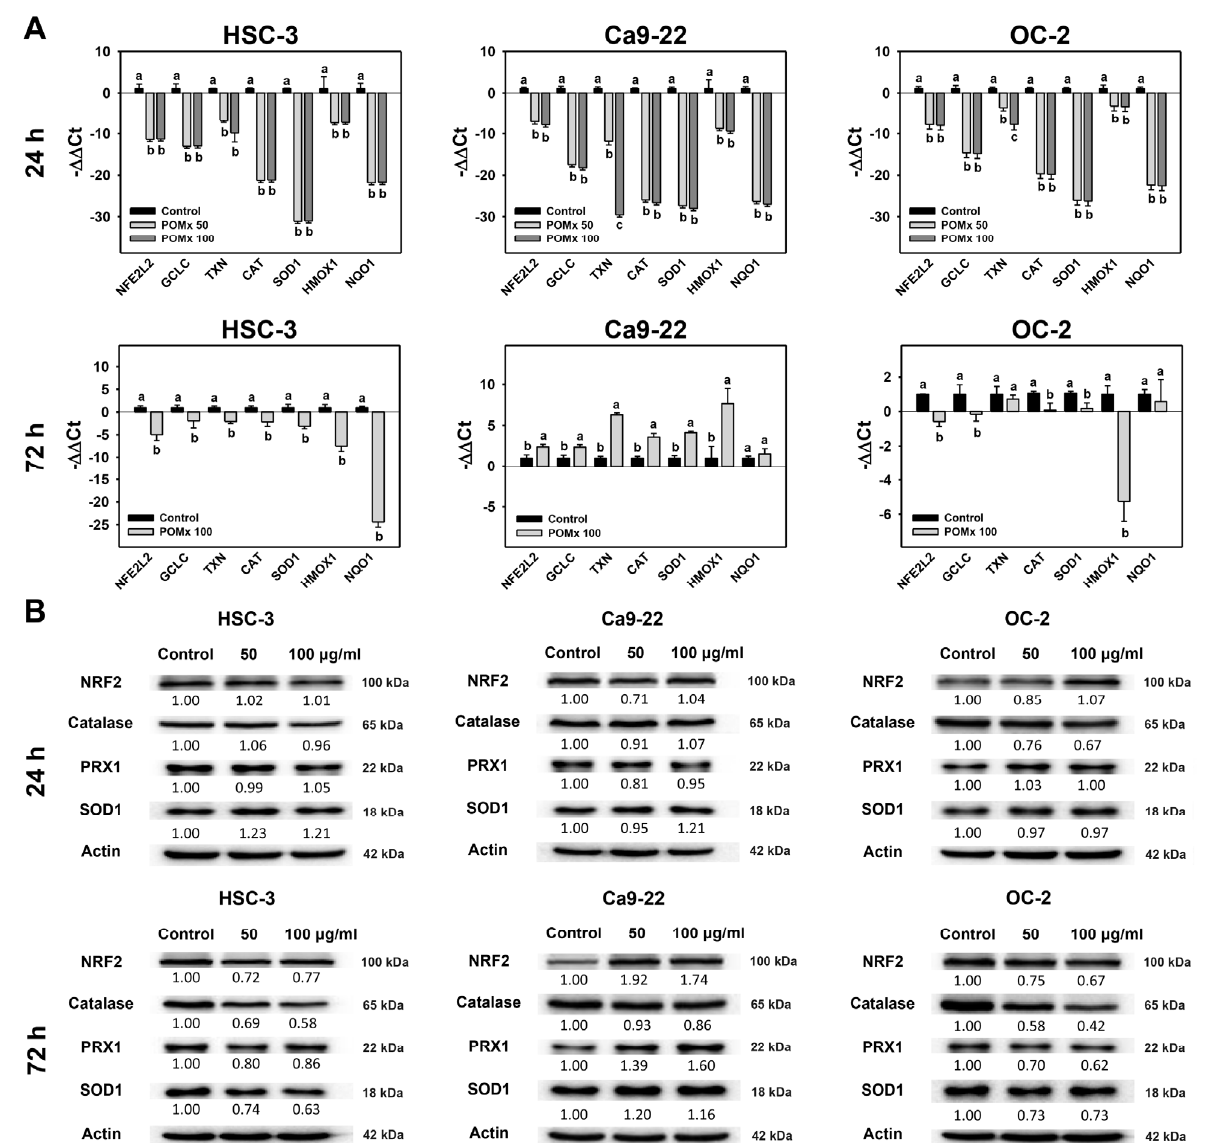
Figure 7. mRNA and protein expressions of antioxidant genes of oral cancer cells after POMx incubation. ( A ) Relative mRNA expressions (log 2 ) of antioxidant genes of oral cancer cells after POMx incubation for 24 and 72 h. ( B ) Western blotting for antioxidant signaling proteins for 24 and 72 h. Cells were incubated with 0, 50, and 100 μ g/mL of POMx (control, POMx 50, and POMx 100) for 24 and 72 h. Treatments without overlapping low cases (a to c) indicate significant differences for the same cell lines. p < 0.05. Data, mean ± SD ( n = 3).